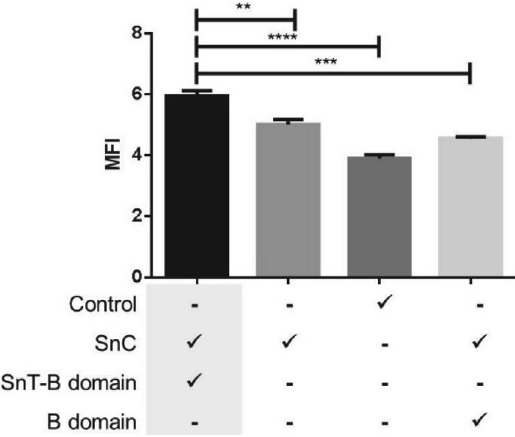
Fig. 7. Flow cytometric analysis of binding of L. lactis -secreted SnoopTag (SnoopT)-B domain to L. lactis cells displaying Snoop- Catcher (SnoopC) on their surface after co-culturing of the two strains. FITC-conjugated human IgG was used for detection. Mean fluorescence intensity (MFI) values were compared to those of con- trols using Student’s t test. ** p<0.01, *** p<0.001, ****